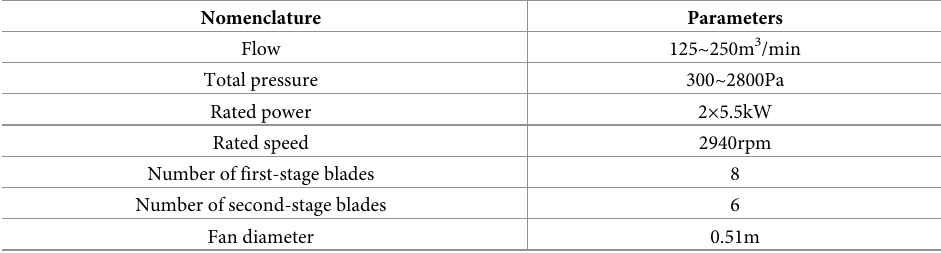
Table 1. Parameters of KDF-5